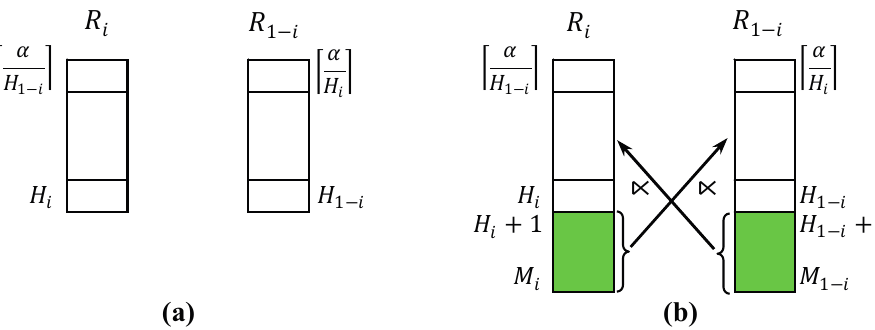
Figure 5. State of (cid:2174)